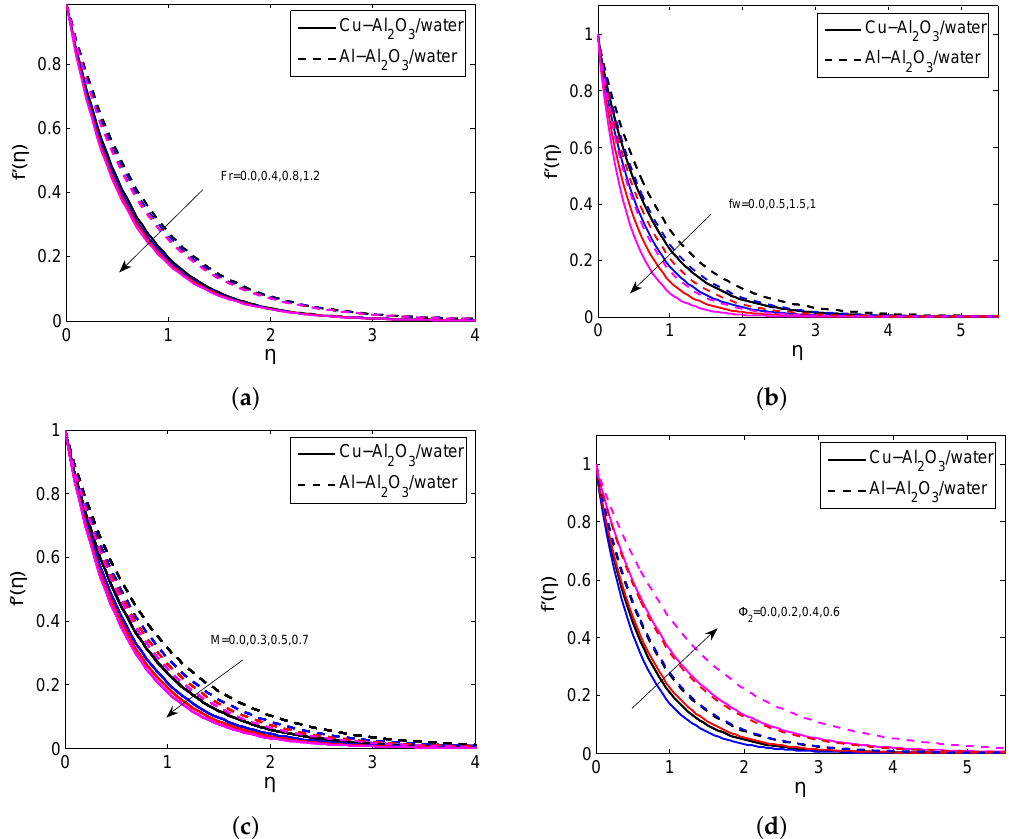
Figure 2. The impact of Fr ( a ), fw ( b ), M ( c ), φ 2 ( d ) on f (cid:48) ( η ) for both